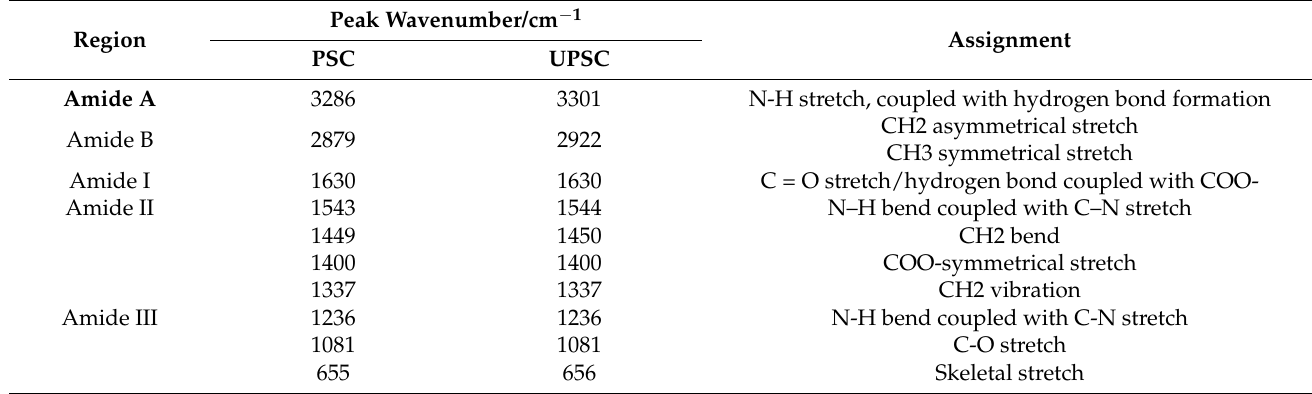
Table 2. PSC and UPSC FTIR spectra peak locations and assignments.